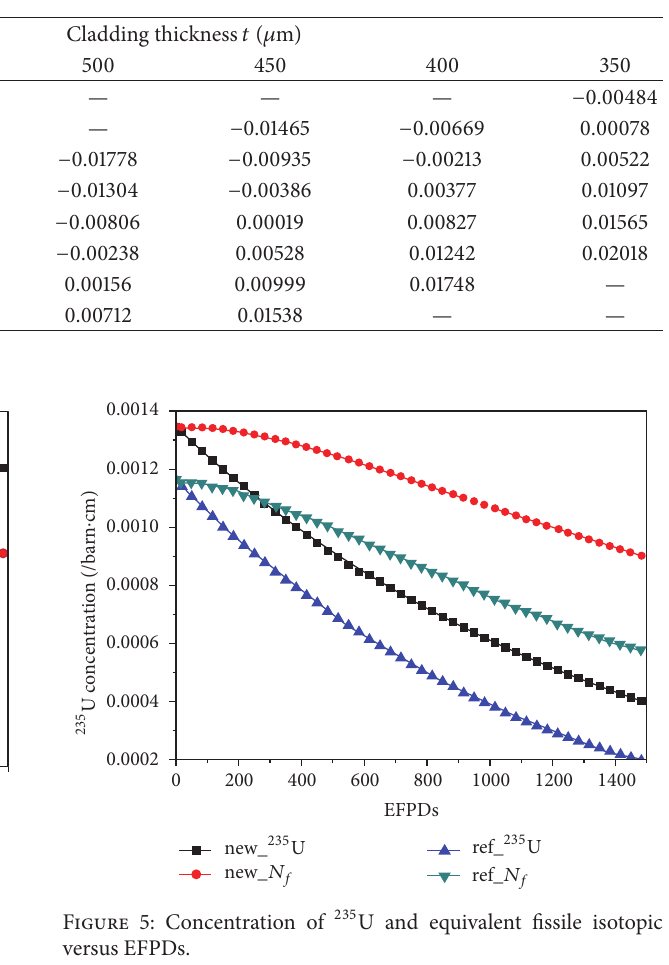
Table 3: Cycle reactivity difference Δ𝑘 core between the U 3 Si 2 -FeCrAl and reference system.